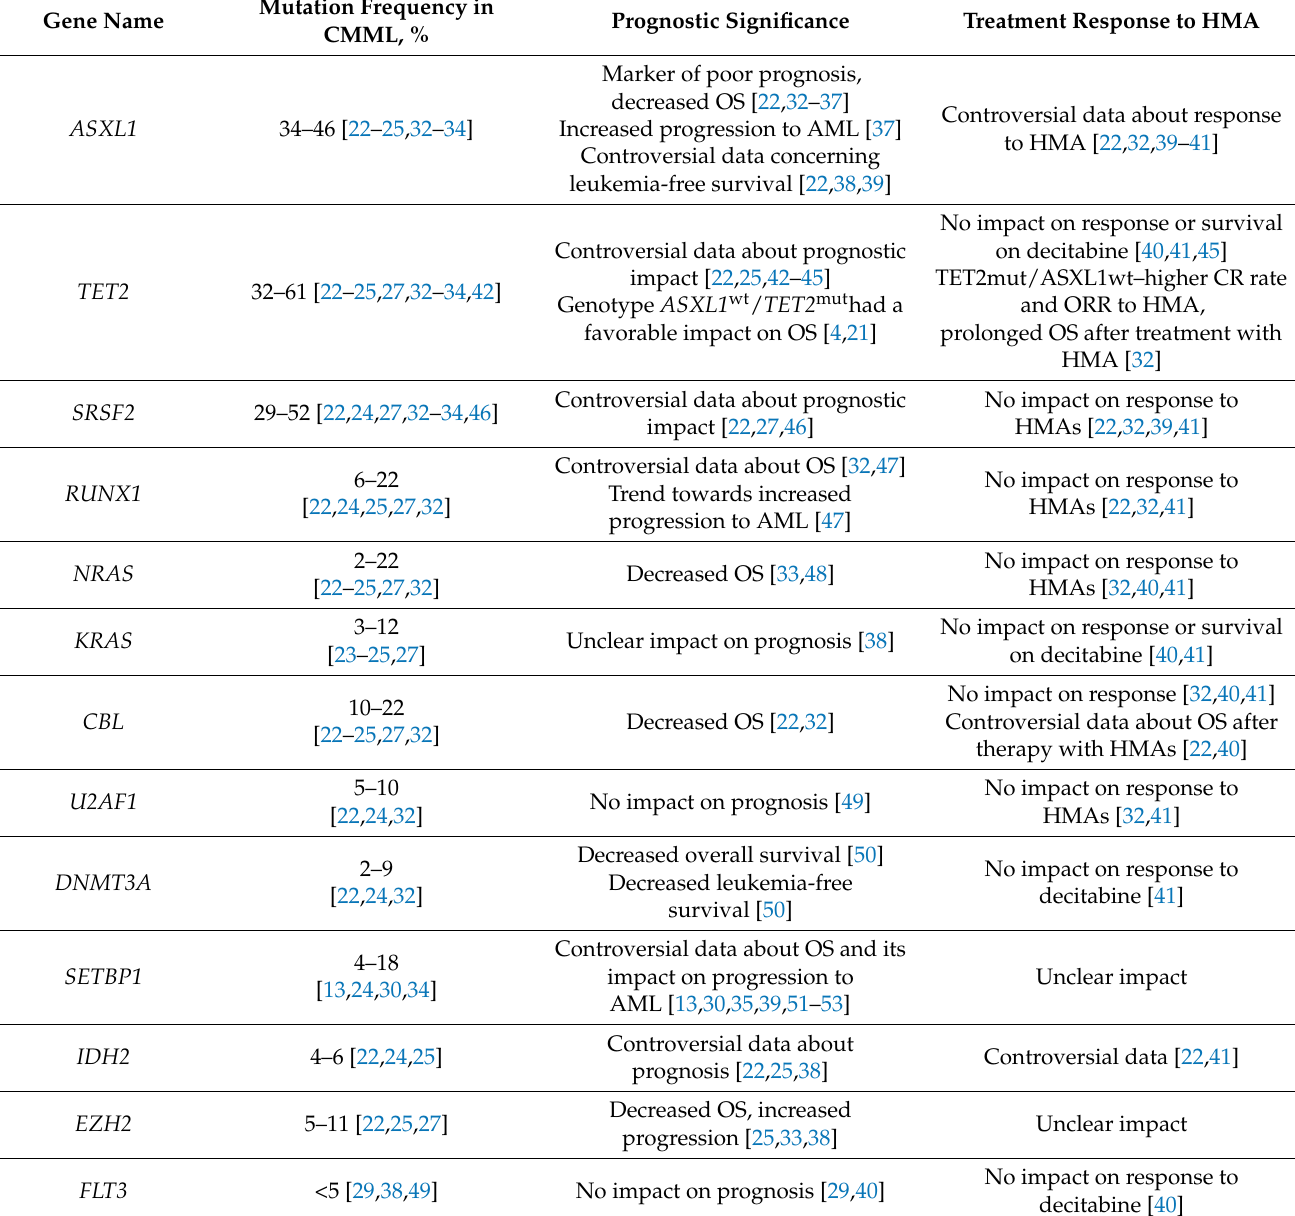
Table 1. The most frequently mutated genes in